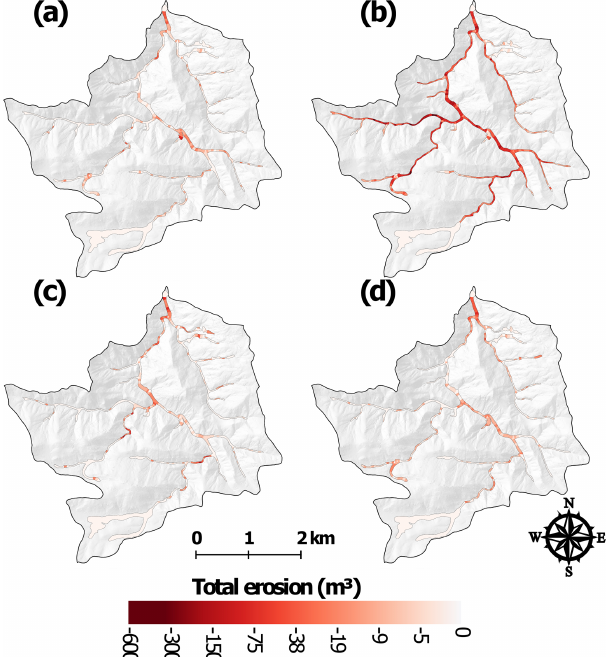
Figure A2. Total erosion for each valley bottom segment in Hill Gulch for (a) 201210–201307, (b) 201307–201310, (c) 201310–201409, and (d) 201409–201506. Calculated volumes are not reported for the transparent segments due to unrealistically wide valley widths, repeat excavations, or the ground surface not being reliably